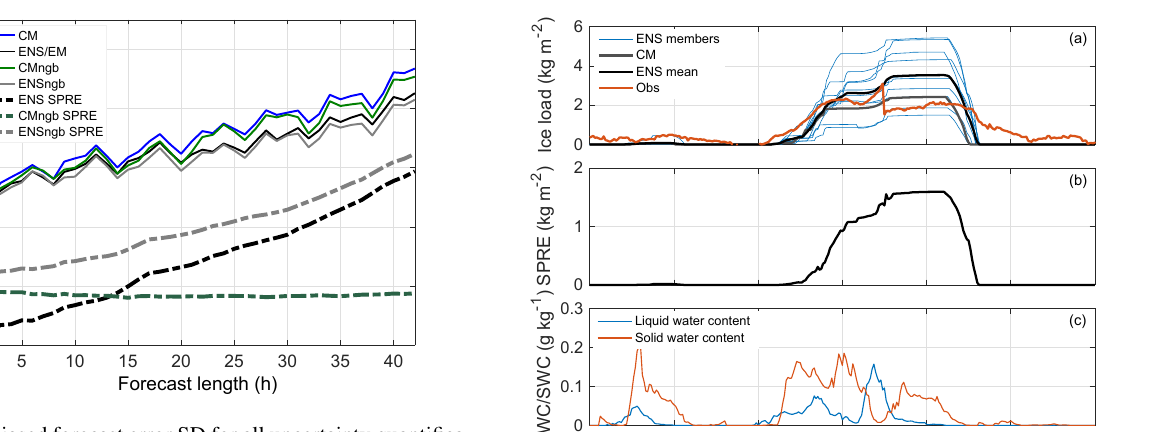
Figure 5. Unbiased forecast error SD for all uncertainty quantifica- tion approaches for the temperature in ◦ C and the spread, SPRE, for the three approaches consisting of multiple forecasts as a function of increasing forecast length. The SD is calculated for the average forecast in case of multiple forecasts, i.e. approaches CMngb, ENS and ENSngb.